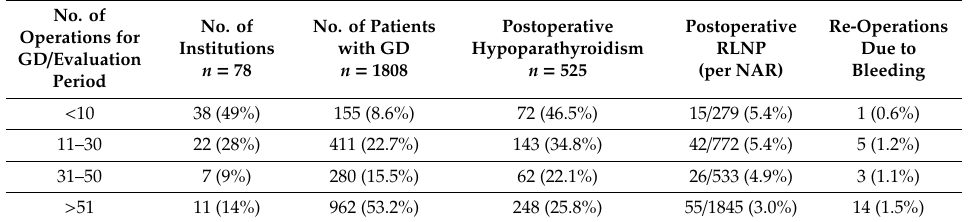
Table 1. Number of operations for Graves’ disease of contributing institutions and corresponding complication